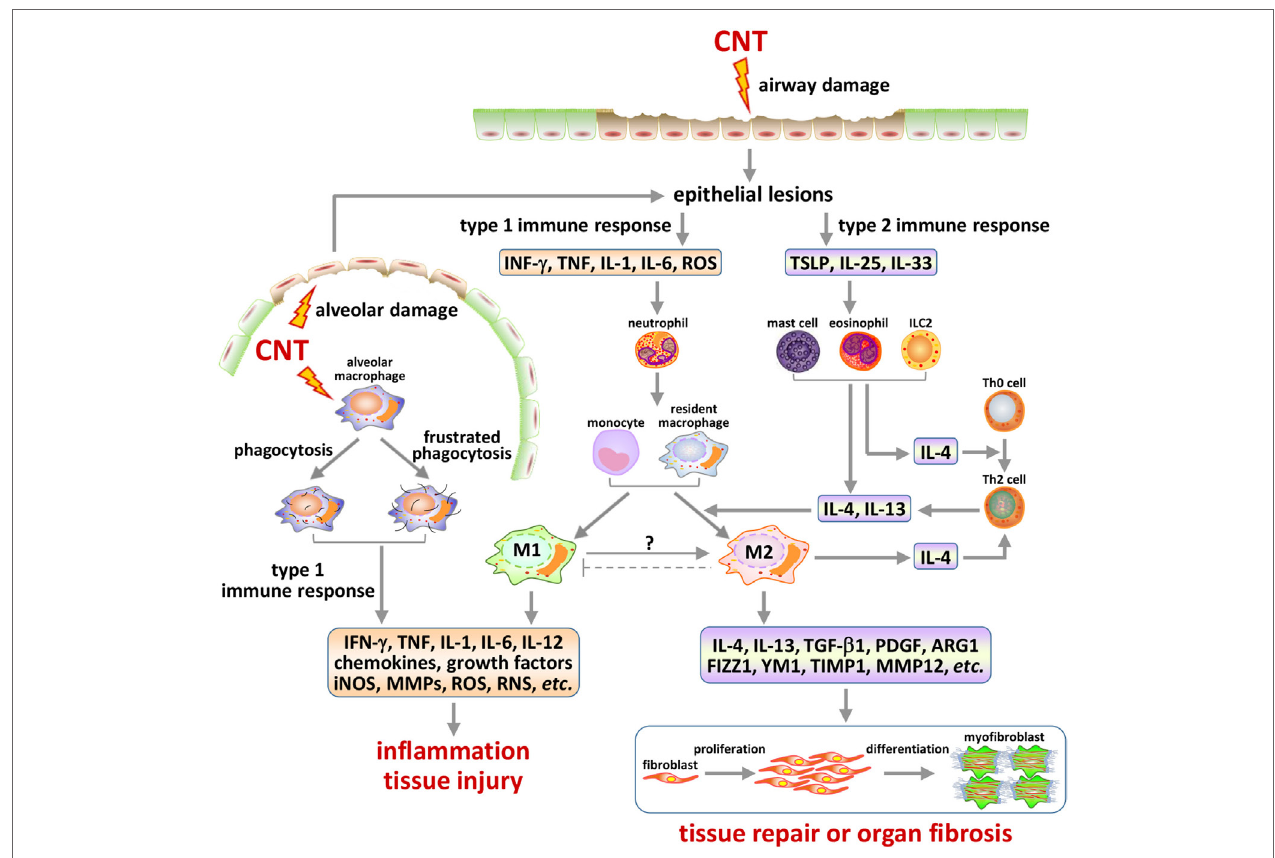
FiGURe 3 | Type 1 and type 2 immune response-associated mechanisms in carbon nanotube (CNT)-induced lung pathology. Inhaled CNTs deposit in airways and in the alveolar space. These nanofibers are capable of inducing epithelial cell lesions via multiple mechanisms, such as generating oxidative stress and penetrating cell membrane. The injury of epithelial barriers, such as of the ciliated epithelial and goblet cells in airways and the type II cells in alveoli, results in the production and release of alarmins that trigger either type 1 or type 2 activities in a time and context-dependent manner. CNTs inhaled deep into the alveolar space can be phagocytosed by alveolar macrophages and induce frustrated phagocytosis, both of which serve as another major source of type 1 mediators and alveolar damage. Type 1 responses may consist of the differentiation and activation of Th1 cells and M1 macrophages, which produce pro-inflammatory and cytotoxic factors, resulting in acute inflammation and injury of local tissues. Type 2 responses are marked by the differentiation and activation of Th2 cells and M2 macrophages, which produce anti-inflammatory and pro-fibrotic factors, leading to suppression of acute inflammation and repair of damaged tissues, or organ fibrosis in the presence of persistent or repetitive fibrogenic stimuli. The activation of these immune response-associated pathways, as well as the interplays among them, plays important roles in the initiation, propagation, and chronic development of CNT-induced lung